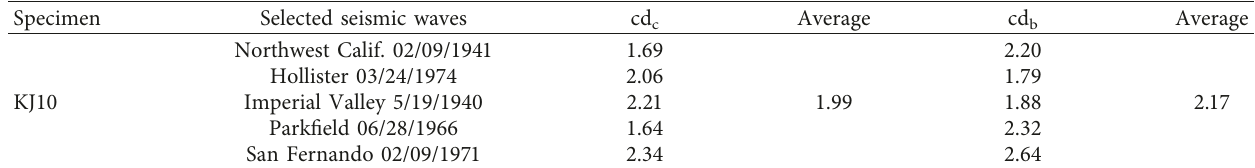
Table 28: Maximum curvature ductility coefficients of beams and columns in model KJ10.